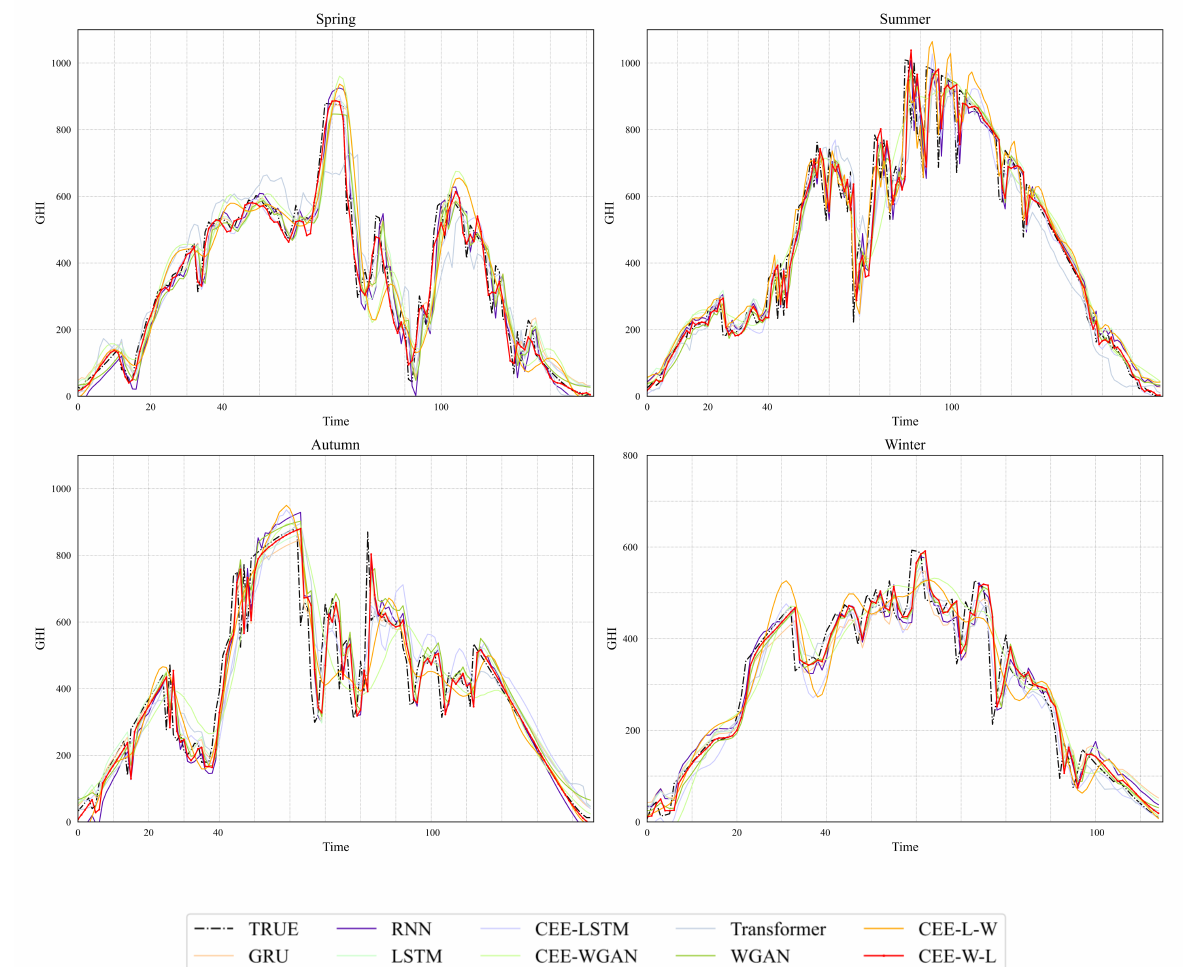
Figure 5. The comparison chart of the data of the four seasons using the different methods. The four graphs in the figure represent spring, summer, autumn, and winter,